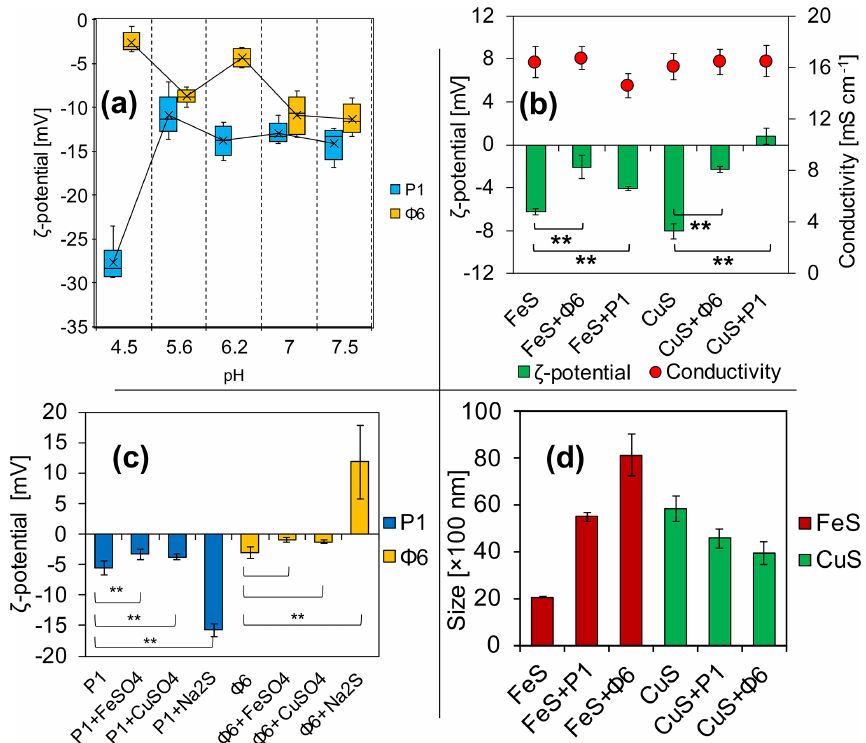
Figure 3. Electrochemical properties of (a) viruses in phosphate buffers and (b) ζ potential and conductivity of FeS and CuS precipitated with or without viruses directly after the experiment; (c) changes in the ζ potential of bacteriophages with added solutions; (d) Z -average size distribution of FeS and CuS precipitated with or without viruses directly after the experiment. **indicates statistical